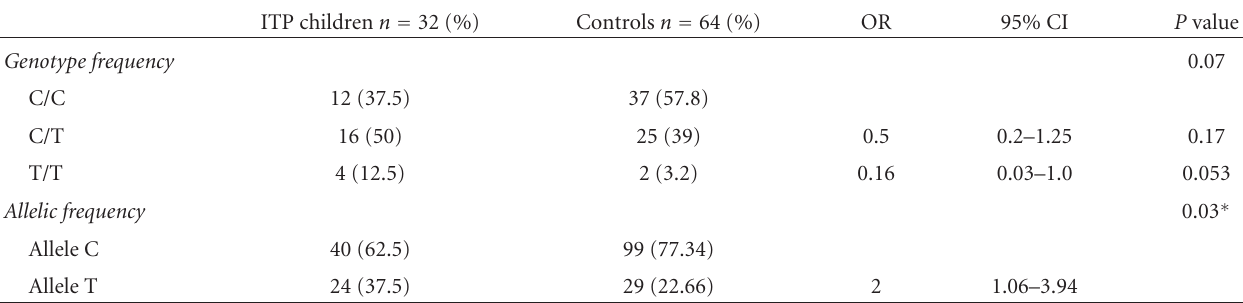
Table 2: Distribution of rs2424913 DNMT3B allele and genotype frequencies in children with ITP and